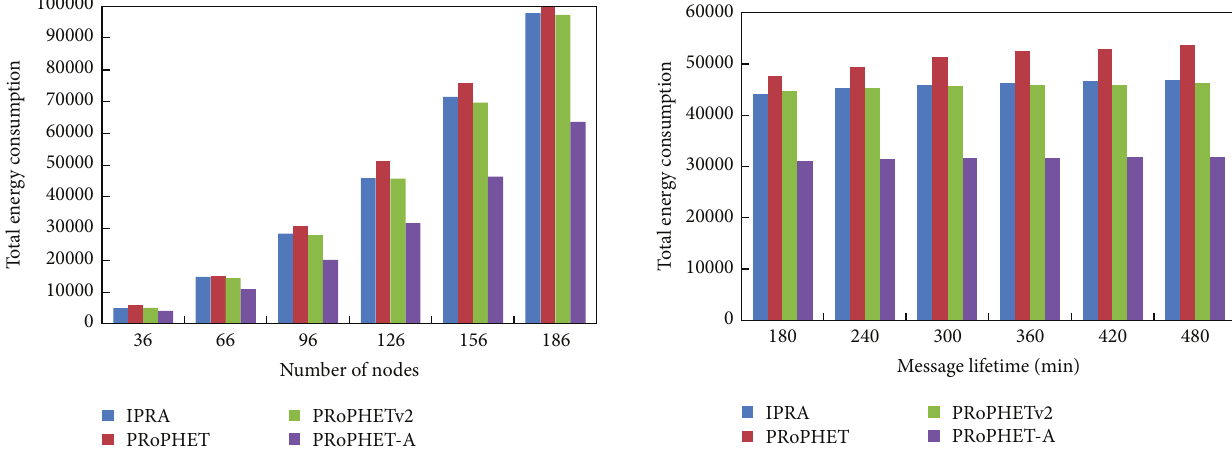
Figure 16: Total energy consumption (TEC) versus number of nodes.